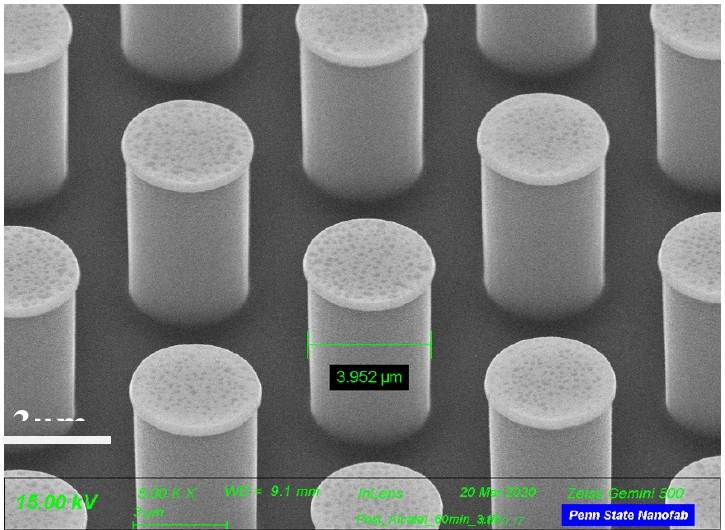
Figure 2. Micropillars without oxide layer. The diameter of the pillar is 3.952 μ m.